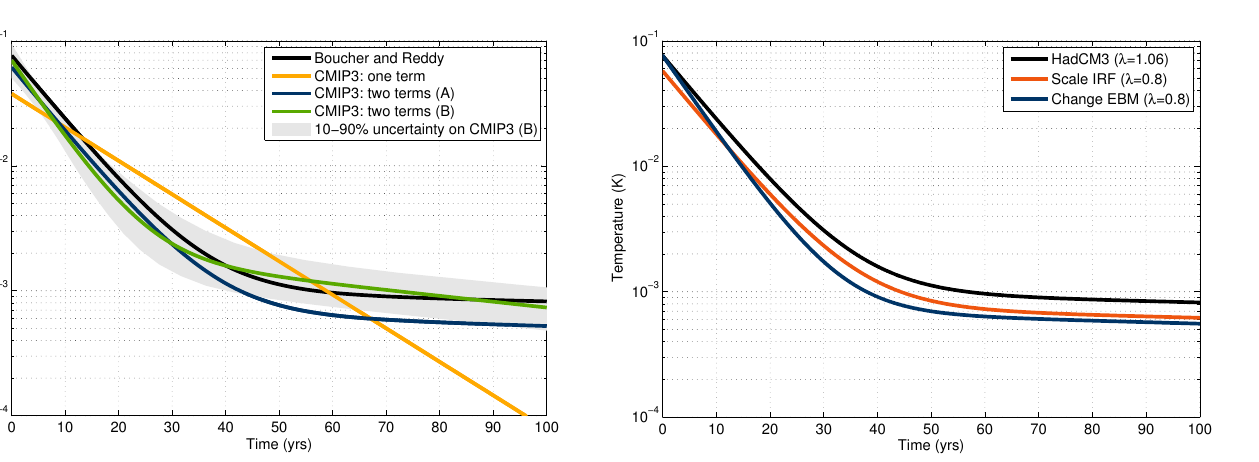
Fig. 3. The IRF from the Hadley model (Boucher and Reddy, 2008) compared to the Hadley IRF ( λ = 1 . 06) scaled to λ = 0 . 8 and with the λ changed in a two-layer energy balance model (EBM) leading to different time